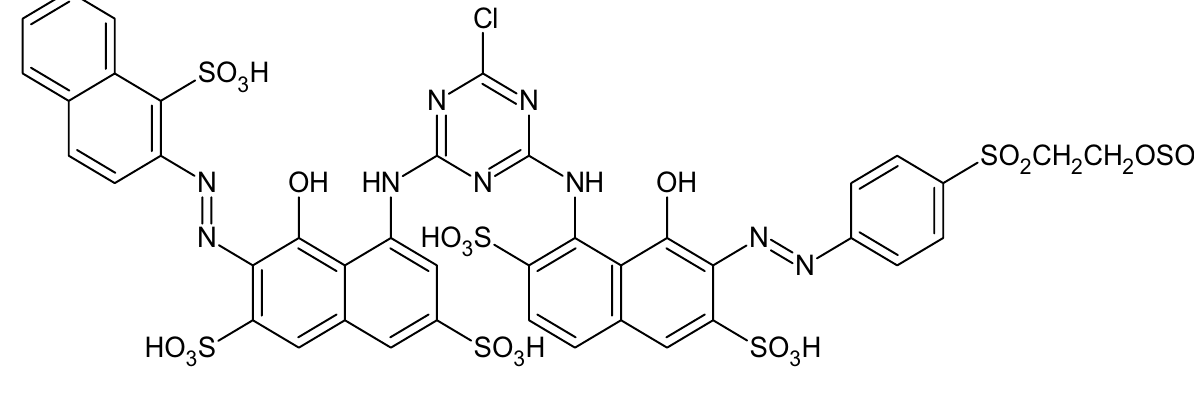
Figure 2. Structure of Red DSBR.